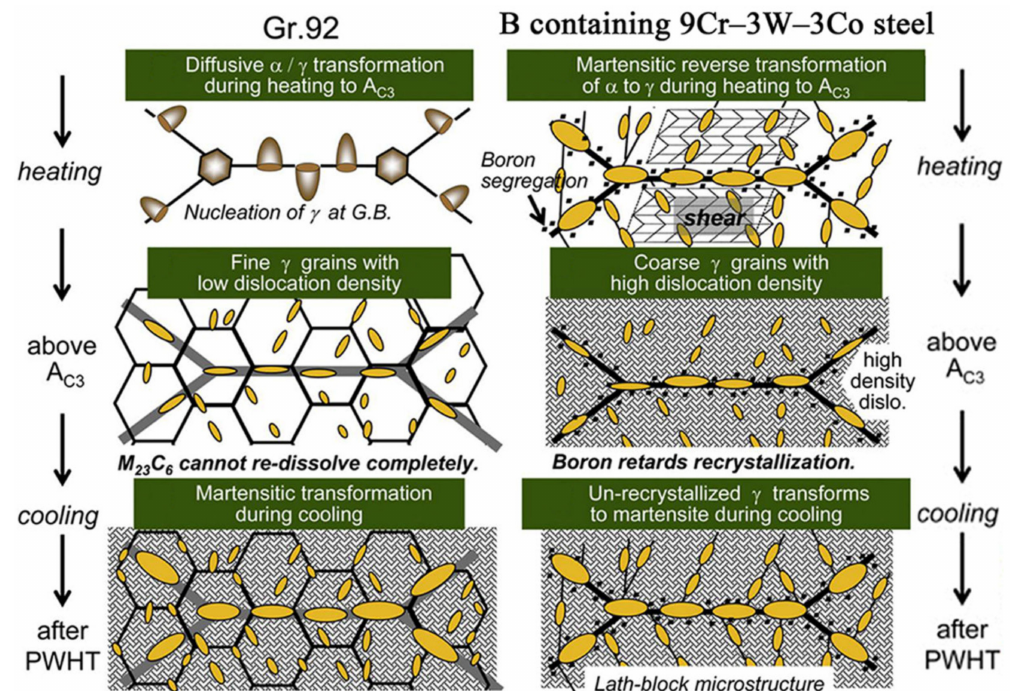
Figure 7. Schematic diagram of microstructure evolution in Gr.92 and 130B 9Cr–3W–3Co steel during A C 3 HAZ thermal simulation [72].